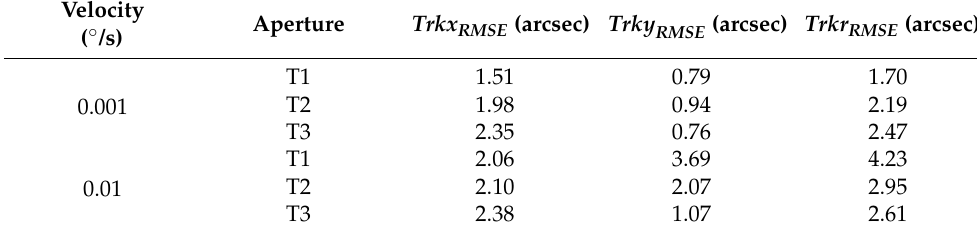
Figure 8. The tracking error as a function of time for each sub-aperture for ( a ) x-direction of trajectory-1 , ( b ) y-direction of trajectory-1 , ( c ) x-direction of trajectory-2 , ( d ) y-direction of trajectory- 2 . Table 3. RMSE of tracking for each sub-aperture.